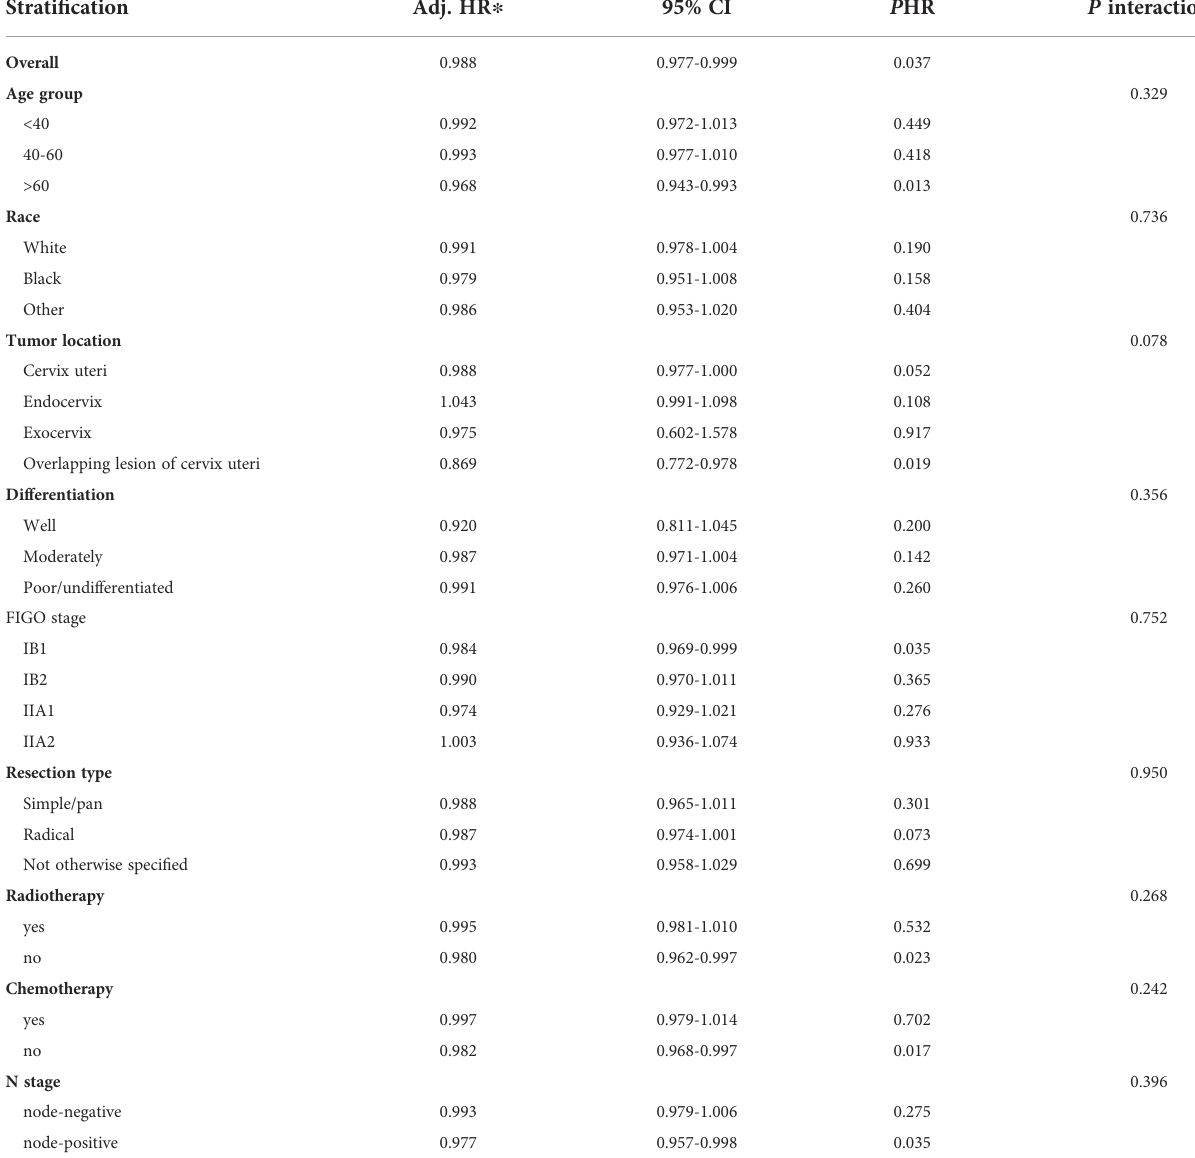
TABLE 4 Association of examined lymph node number (as a continuous variable) with overall survival in subgroups by clinicopathological types and treatment factors. Strati fi cation